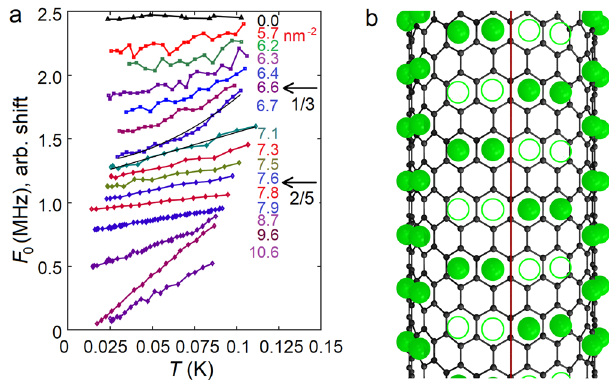
Fig. 4 | Vacancies on a nanotube. a Temperature dependence of resonant fre- quency F 0 at different coverages. Curves are shifted arbitrarily in the vertical direction. We fi nd F 0 ( T ) − F 0 (0) ∝ T β with β ≃ 2 at coverages ⩽ 6.7nm − 2 , which corre- sponds to 1D phonons in a solid. The quadratic behavior changes abruptly to a linear at ρ ≈ 7.1nm − 2 , which persists till complete monolayer coverage. Linear temperature dependence can be obtained with constant number of weakly inter- acting excitations, such as vacancies induced by topological mismatch. The quadratic fi t for the highest coverage 6.7nm − 2 of the 1/3 solid, and the linear fi t for the lowest coverage 7.1nm − 2 of gliding solid are shown by black curves. b Illustration of mismatch-induced defects in high-coverage 3 He superlattice adsorbed on a CNT. The defects are produced when a graphene sheet with helium superlatticeon itisrolled around the vertical axisto form a CNT.Thedimerized 2/ 5 superlattice is depicted as an example. The red line shows the gluing of edges of the graphene stencil. Empty circles illustrate vacancies created by the